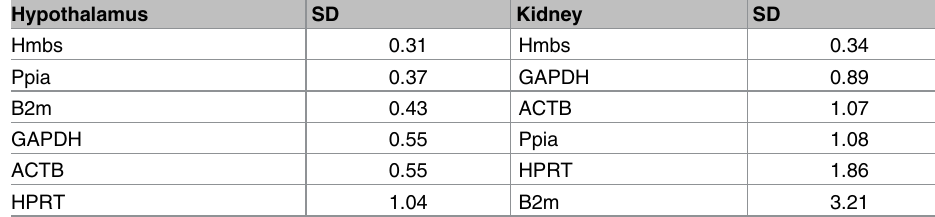
Table 2. Shows the expressional stability of selected referencegenes, using NormFinder in hypothal- amus and kidney. NormFinderalgorithmis based on model-based approach to calculateoverall reference gene stability. Gene with lower standarddeviation(SD) is consider the most stable gene. In both tissues Hmbs is the most stable gene while in hypothalamus HPRT and in kidney B2m is the least stable